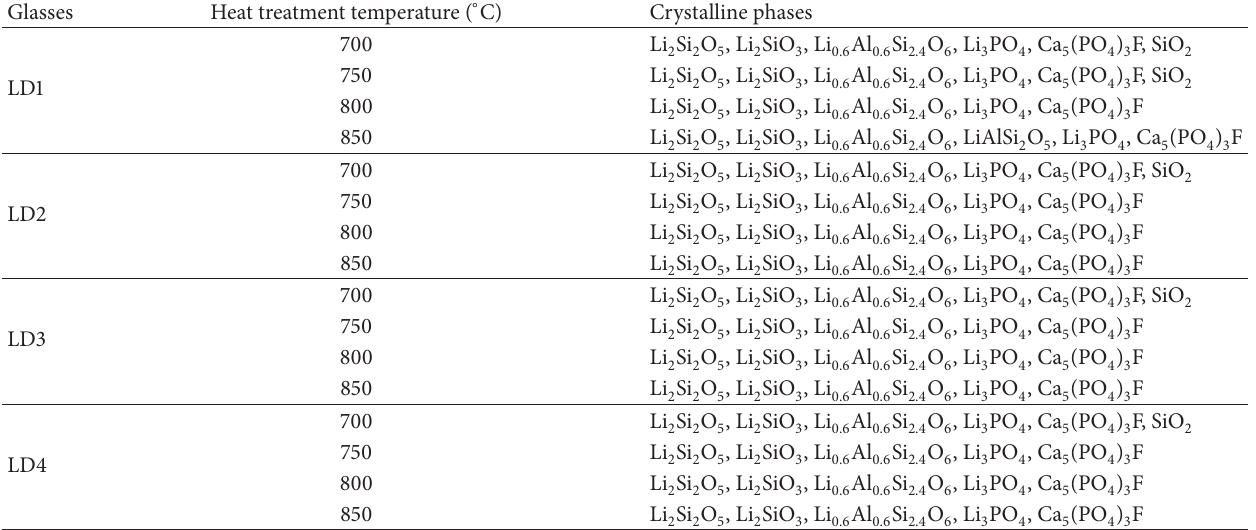
Table 3: Summary of crystalline